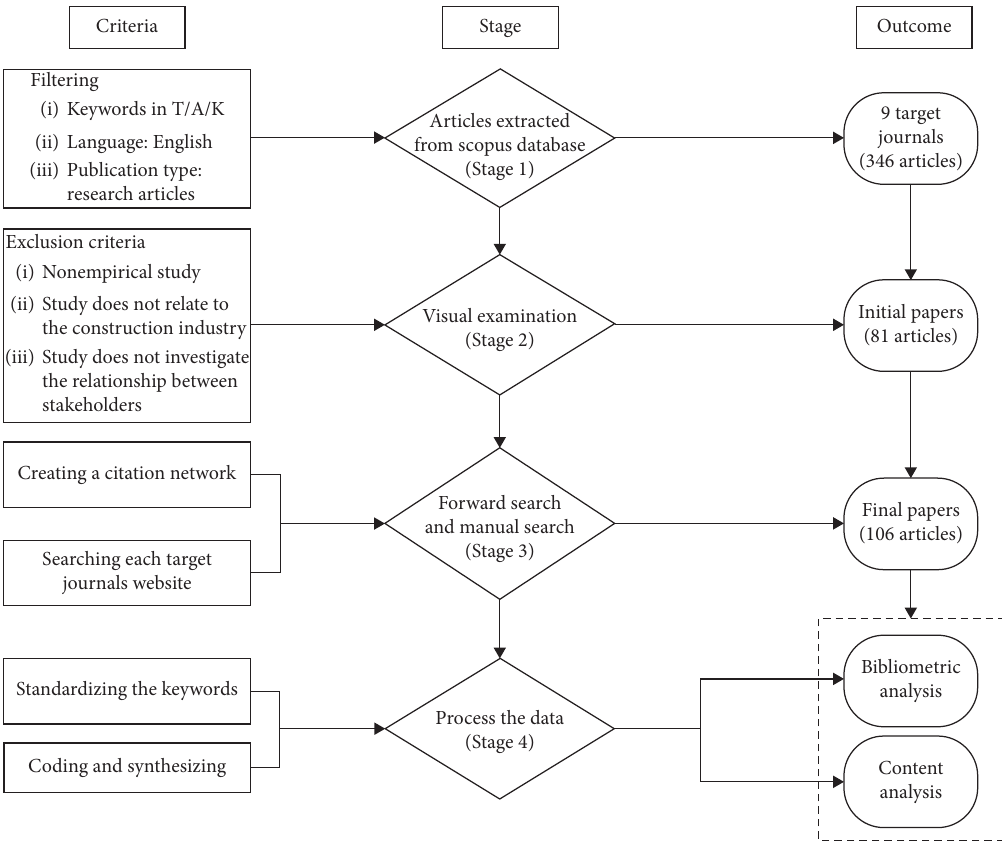
Figure 1: Research